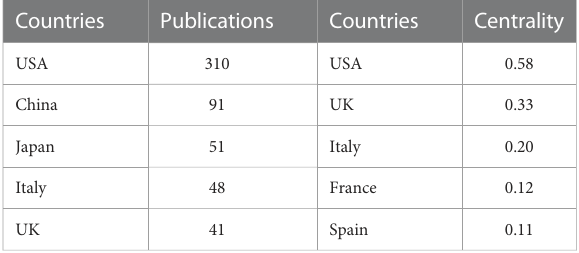
TABLE 2 The top 10 countries/regions involved in